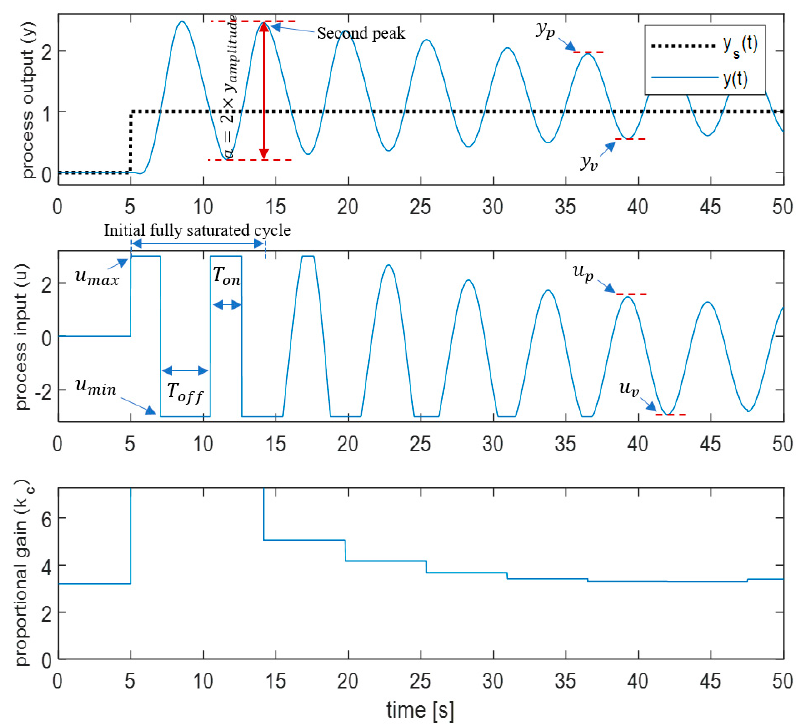
Figure 2. Typical response of the proposed method.